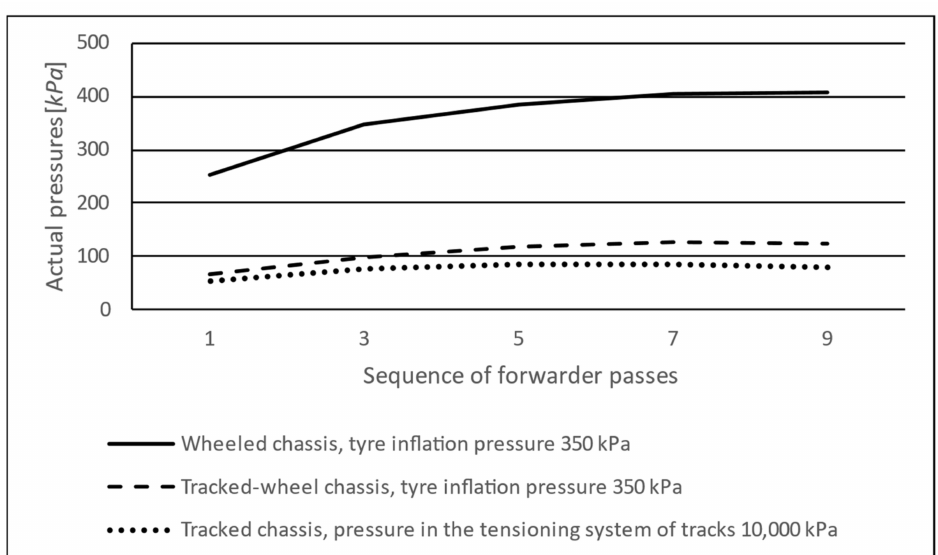
Figure 7. The course of induced actual pressures of rear axles in the respective forwarder chassis variants with the load during the first 10 passes.